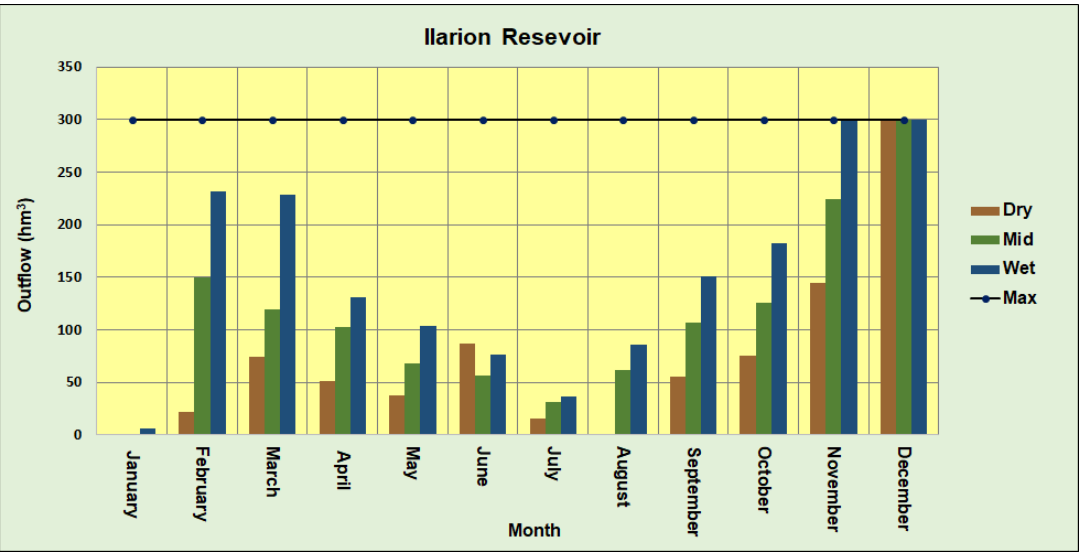
Figure 7. The optimal outflows for the current state of water resources demand, ignoring the institutional operating rule curves for the Ilarion reservoir.